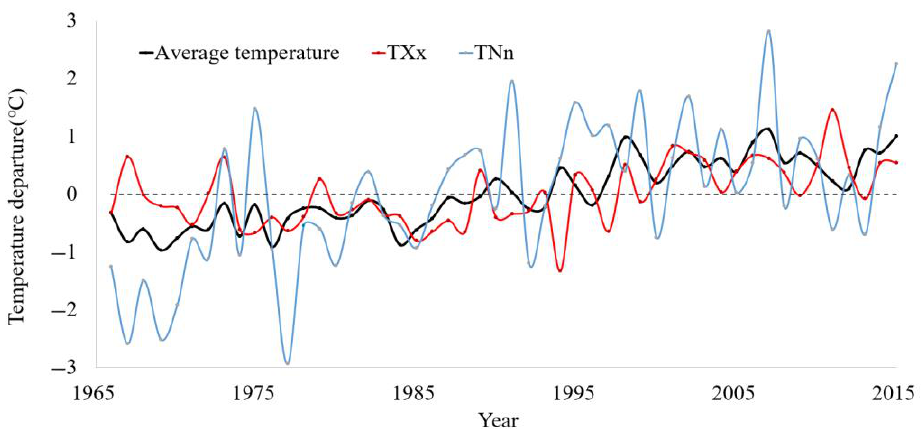
Figure 8. Temporal variation of annual average temperature, TXx and TNn dispersion for China from 1966 to 2015.